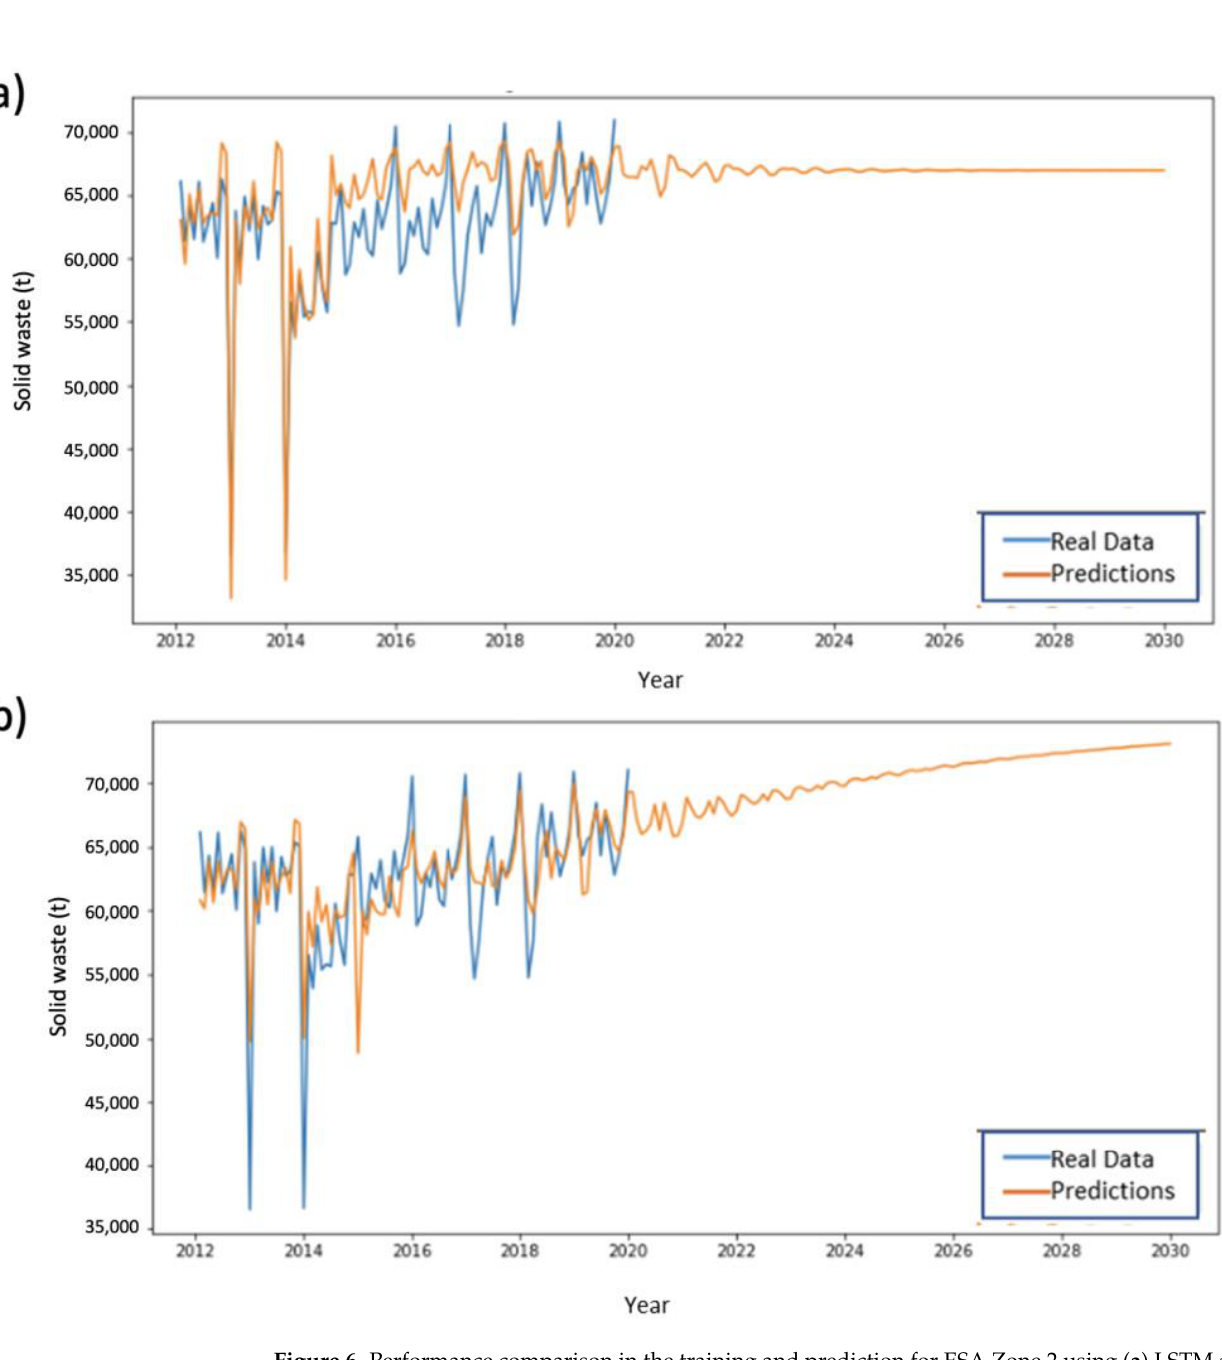
Figure 6. Performance comparison in the training and prediction for ESA Zone 2 using ( a ) LSTM and ( b ) SVMs.